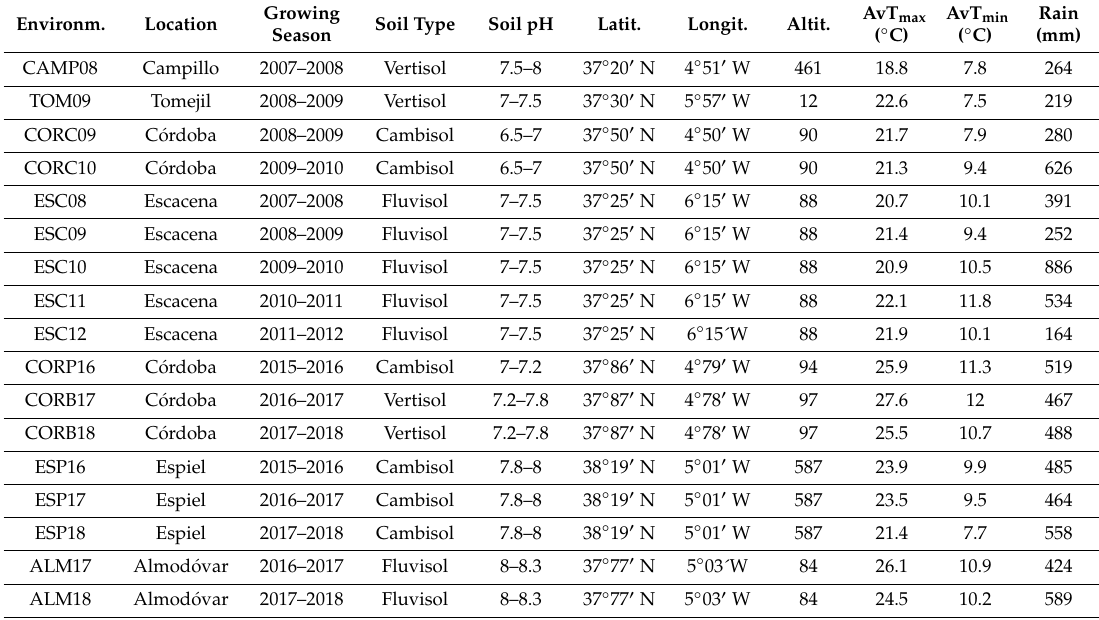
Table 1. The description of the environments (combination of location and season) of the trials. Environm.